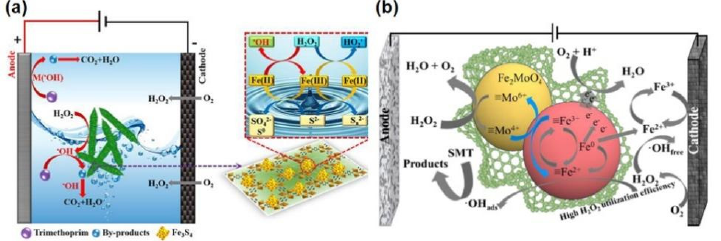
Figure 11. ( a ) Schematic illustration of the reaction mechanism for the S − MIL − 88B − 3h − 3 − catalyzed degradation of TMP [70]; ( b ) Schematic illustration of the mechanism in the FeMo@PC − 2/Hetero-EF process [71].